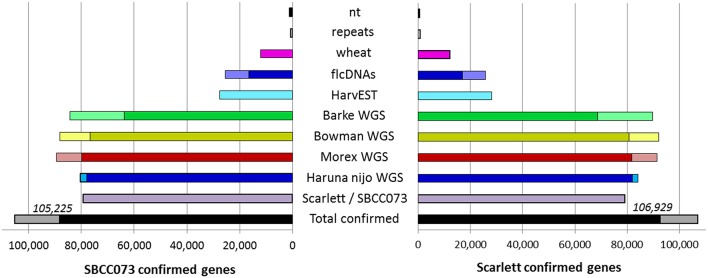
De novo assembled genes confirmed in existing barley references. Bars indicate the number of assembled genes of landrace SBCC073 (left) and cultivar Scarlett (right) which were confirmed by alignment to each other, and to several sequence repositories of barley and wheat (for list, see text). The total number of genes confirmed for each of the two assemblies is also shown (bottom black/gray bars). The alignments required 98% identity and a minimum alignment query coverage of either 10% (whole bars) or 80% (fraction of bars filled with a darker color).